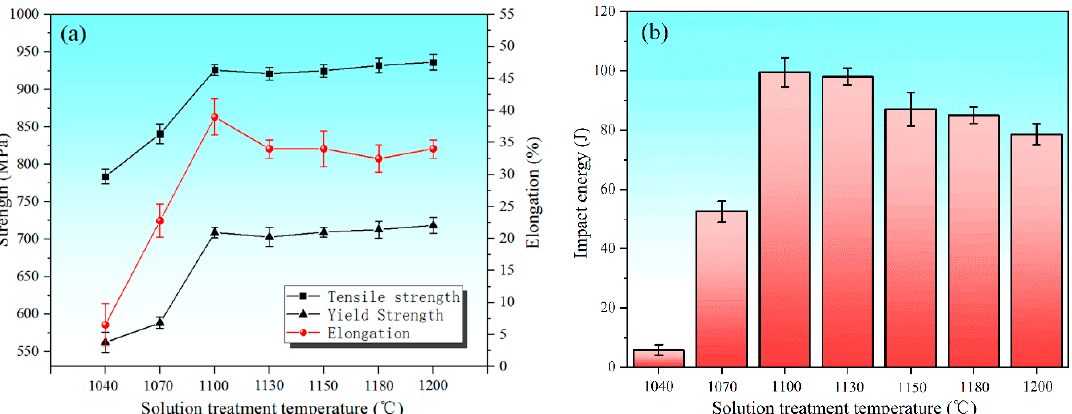
Figure 7. Mechanical properties of specimens with different solution treatment temperatures: ( a ) tensile property and ( b ) Charpy impact energy.